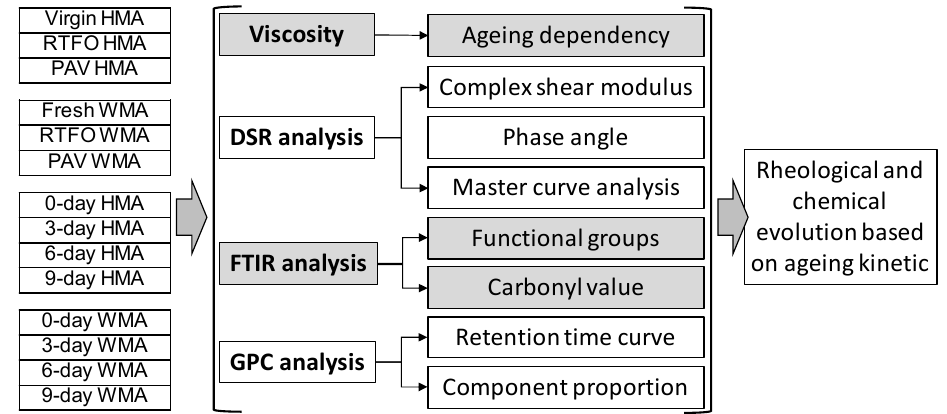
Figure 2. Detailed research program for rheological and chemical evolution study. The dynamic shear rheometer (DSR), with the help of Anton Paar Smart Pave 102 (Graz, Austria), was adopted to characterise the complex modulus and phase angle of the asphalt binder. The test was performed at 20, 25, 30, 40, 50, and 60 °C, using the parallel plates with a diameter of 25 mm with a gap of 2 mm. Before starting the DSR measurement, strain sweeps were performed to determine the linear viscoelastic region of the binder. The WLF equation (WLF = William, Landel, and Ferry) was used to calculate the shift factors to construct master curves.